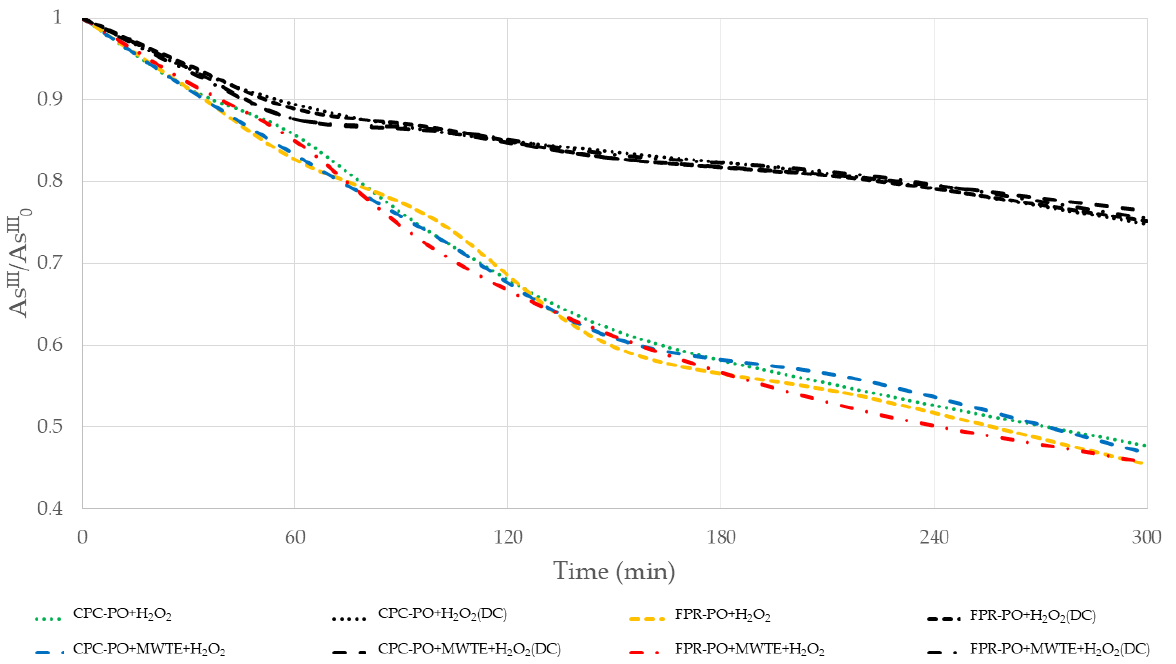
Figure 5. As III photooxidation (PO) experiments carried out both in CPC and FPR, H 2 O 2 added, and with and without MWTE spike. Experiments performed in the dark as control experiments (DC) are included as well.